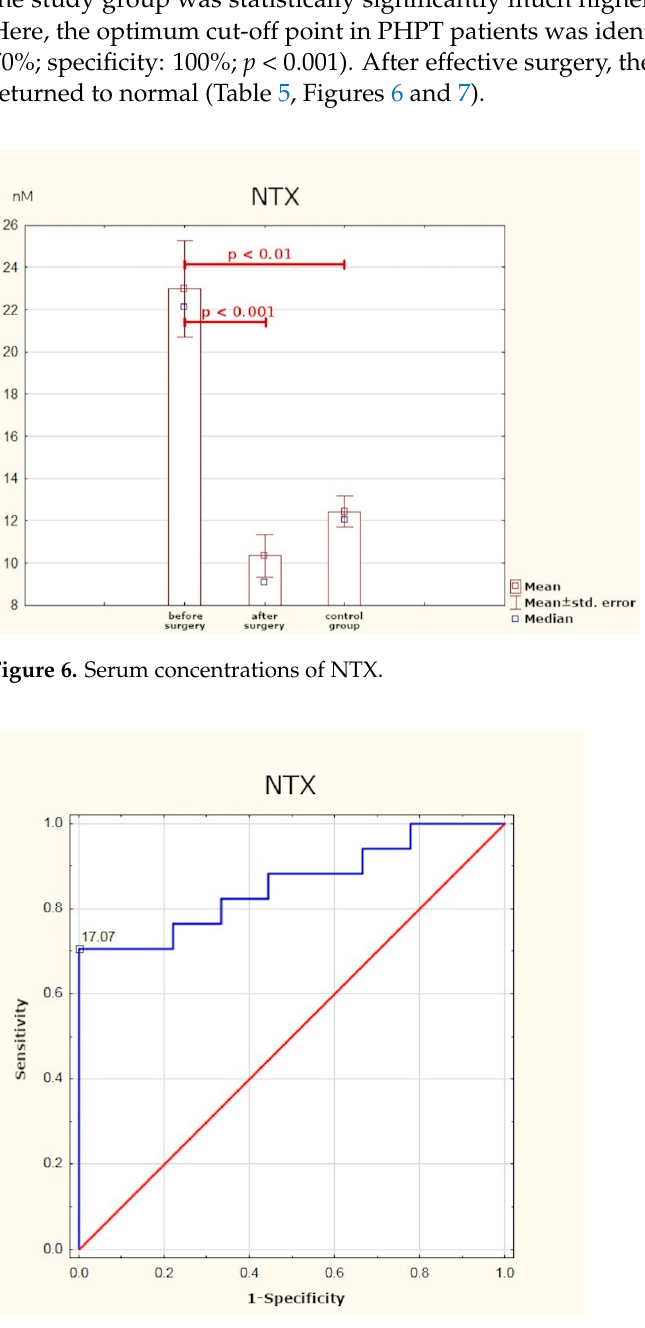
Table 5. Serum concentrations of NTX (N-terminal telopeptide of type I collagen) in study group vs. control group.